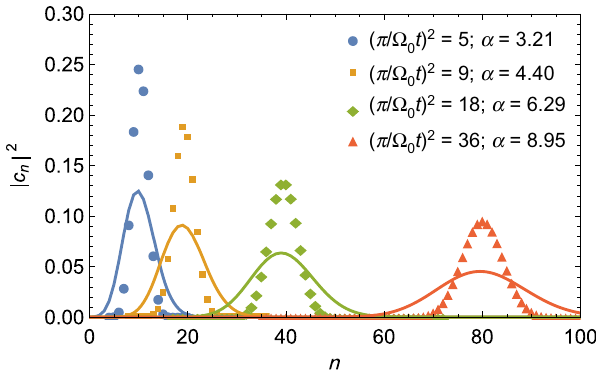
FIG. 2. Probability distribution for field states that perfectly create coherent atomic states from | e (cid:2) in time t . Also plotted are the (Poissonian) probability distributions for coherent states that are classically used for 3 π/ 2 pulses. The ideal field state distri- butions approach number-squeezed coherent states as t decreases and the average energy increases; the number squeezing is much more significant than in Fig.